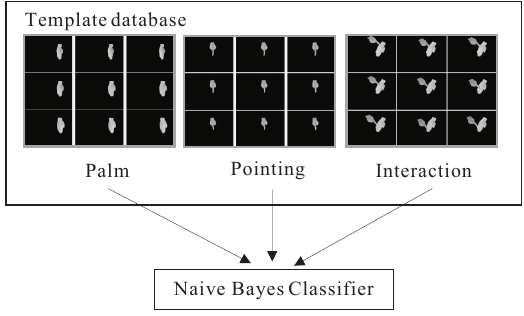
Figure 3: The NBC trained by Hu-moments of hand shapes